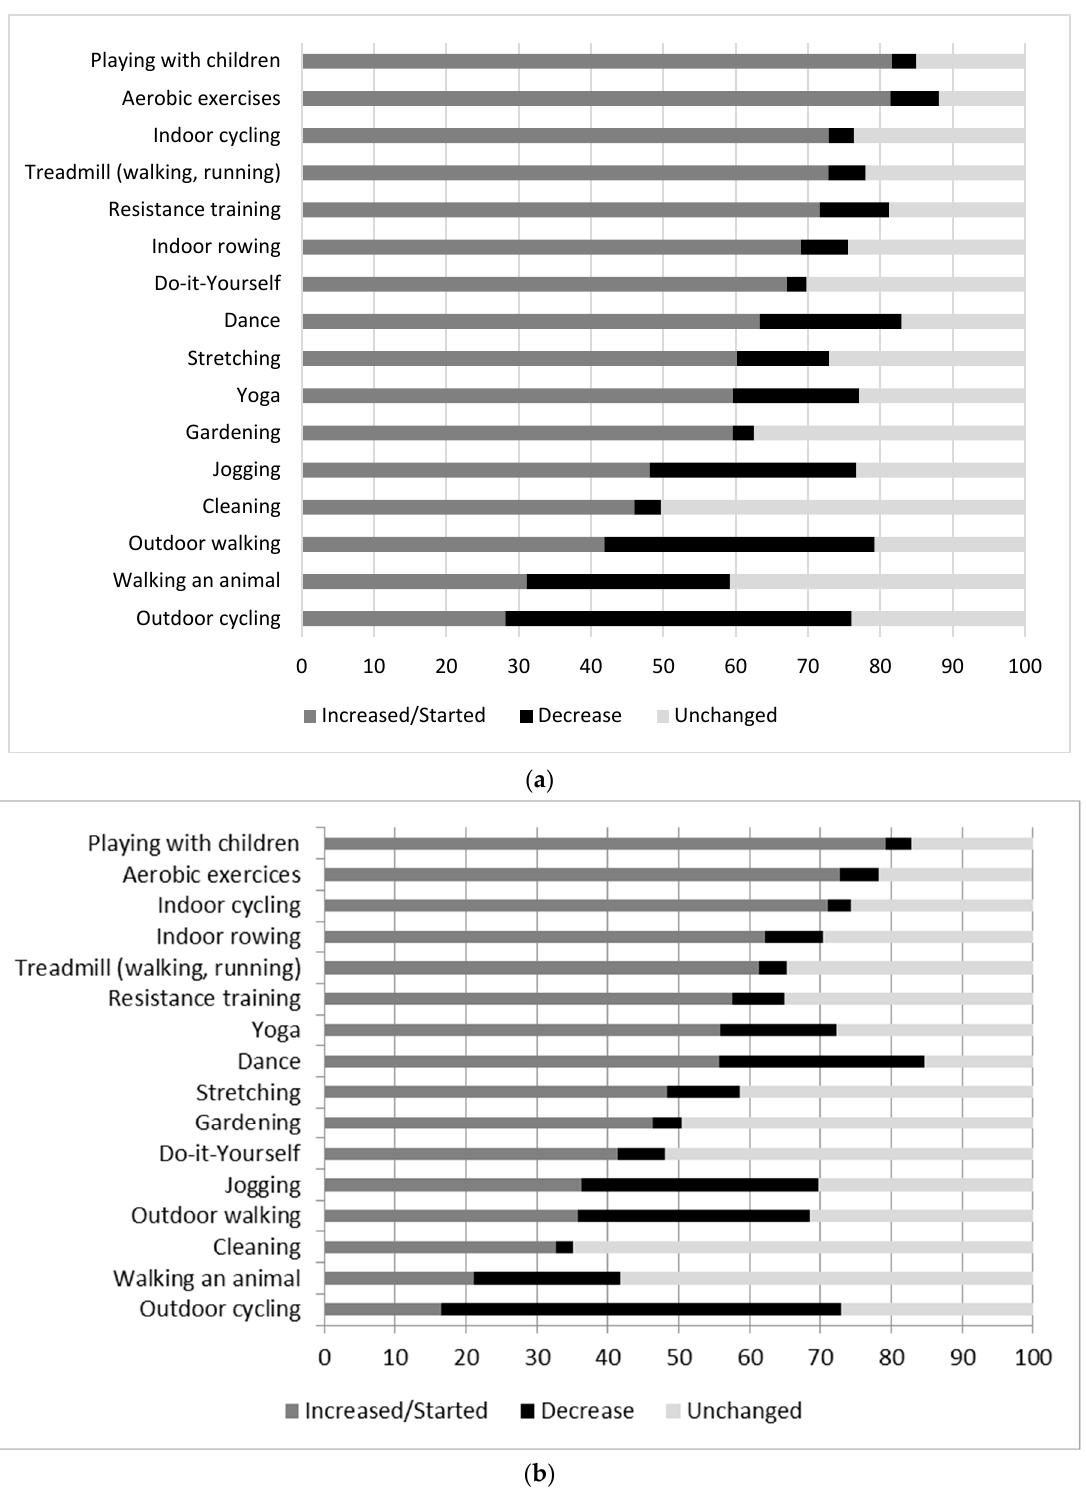
Figure 3. ( a ). Changes (increase, decrease or no change, %) for each type of physical activity among women at T1. ( b ). Changes (increase, decrease, no change, %) for each type of physical activity among men at